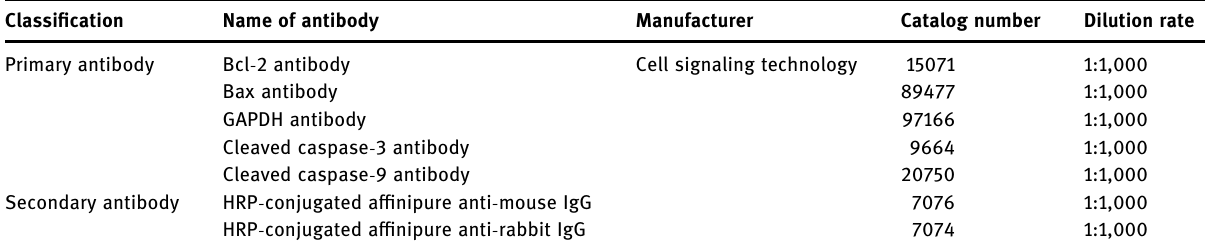
Table 3: Antibodies for western blotting Classi fi cation